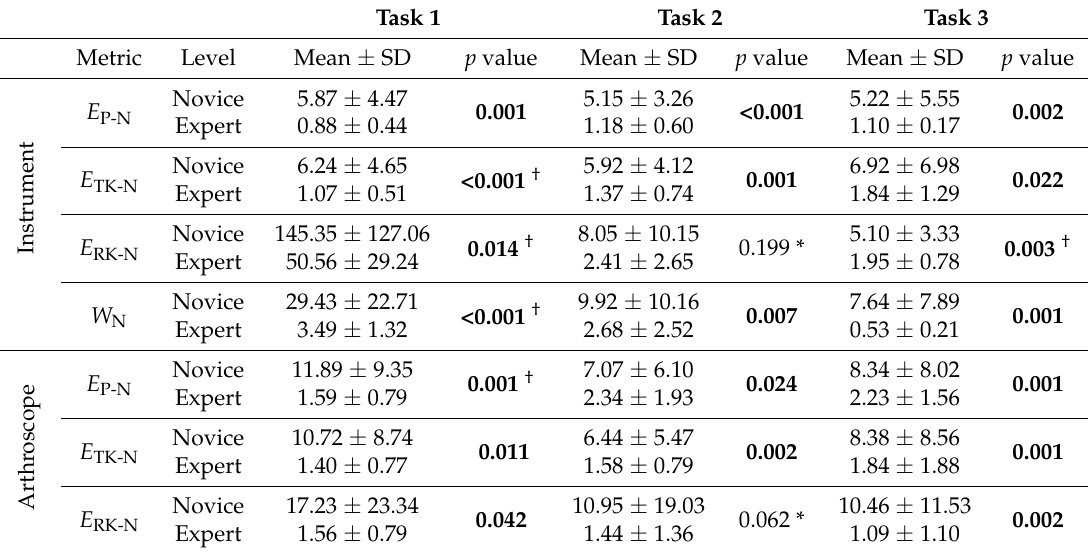
Task 1 Task 2 Task